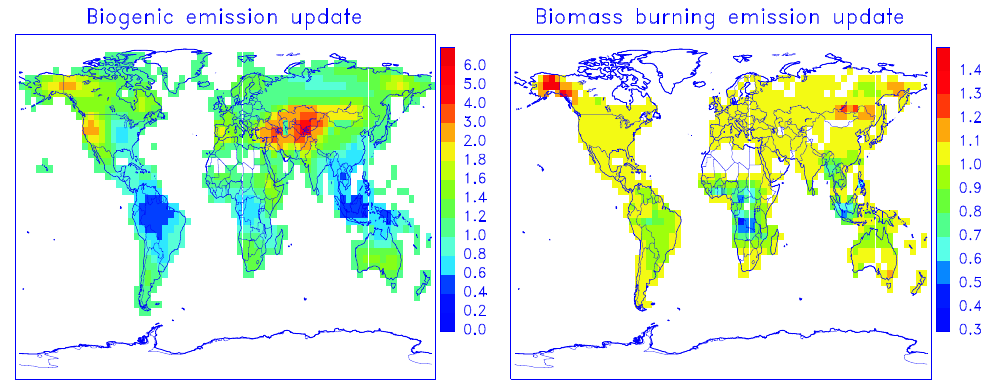
Fig. 4. Annual ratios of a posteriori to a priori biogenic (left) and biomass burning (right) emissions inferred by the OptS2 inversion study.